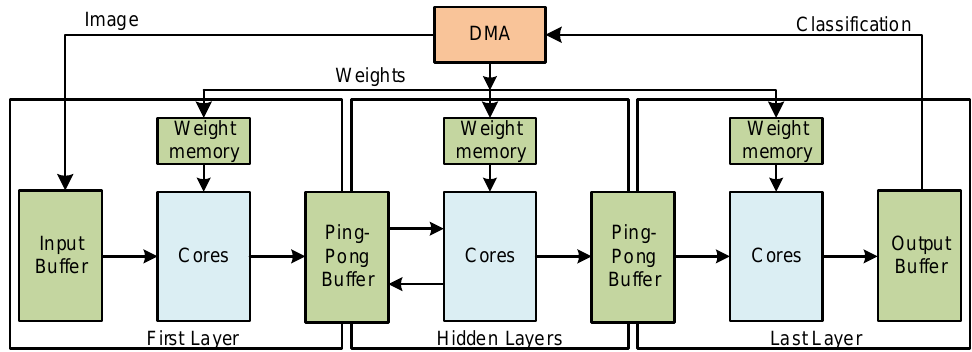
Figure 3. Architecture of the accelerator with the three